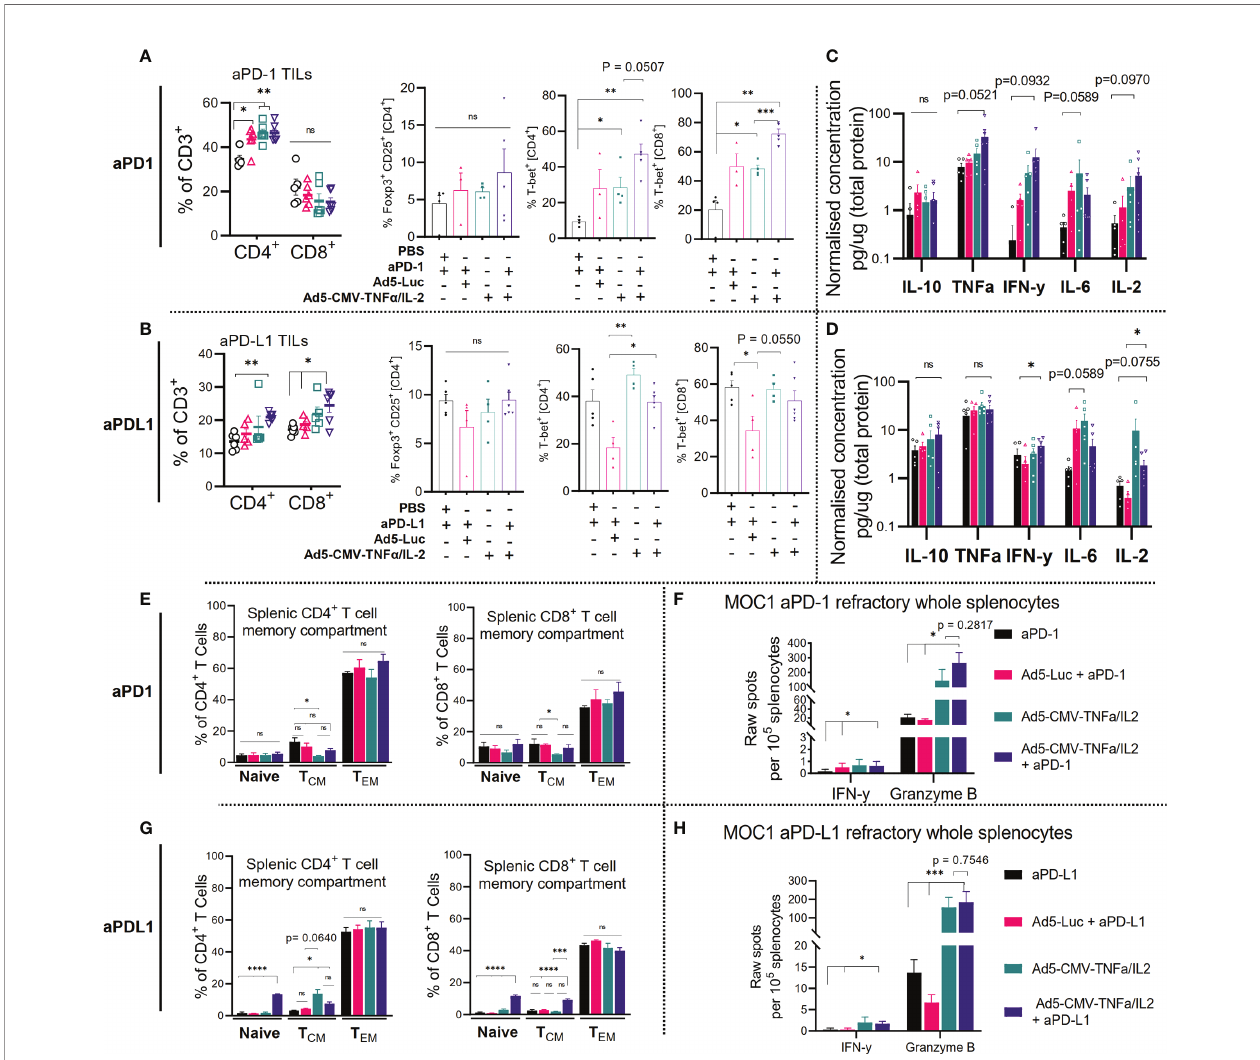
FIGURE 3 | Combining ICI with non-replicative Ad5-CMV-mTNF a /mIL-2 improves traf fi cking and activity of ICI refractory tumor-in fi ltrating-lymphocytes and is re fl ected by changes in the secondary lymphoid organs. (A, C) Flow cytometric quanti fi cation of percentages of CD4 + , CD8 + , Foxp3 + , T-bet + expressing tumor- in fi ltrating lymphocytes is shown for (A). anti-PD-1 (upper panel) and (C) anti-PD-L1 (lower panel) refractory MOC1 tumor-bearing C57BL/6J mice. (B, D) . Bulk tumor proin fl ammatory cytokine analysis as measured by bead based fl ex set. Data are presented as logarithmic values. (E, G) Flow cytometric analysis of CD4 + , CD8 + splenic memory compartment (naïve, effector memory [T EM ], central memory [T CM ]) from MOC1 anti-PD1 (upper) and anti-PD-L1 (lower) refractory mice as measured by ± expression of CD44 and CD62L. (F, H) Corresponding treatment group freshly resected whole splenocyte effector function analysis measured by overnight culture with mGranzyme B and mIFN-y dual-ELISpot. Flow cytometric and bulk cytokine analysis data represent two independent experiments. Statistical signi fi cance for each data set was evaluated by non-parametric unpaired t test. All data are shown as means ± SEM and signi fi cance is represented as *p < 0.05, **p < 0.01, ***p < 0.001, ****p <0.0001, ns, not signi fi